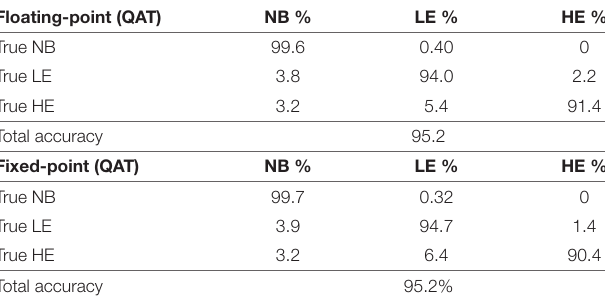
TABLE 9 | Optimized performance for Q-CNN02-DS-OP , with quantization-aware network training.